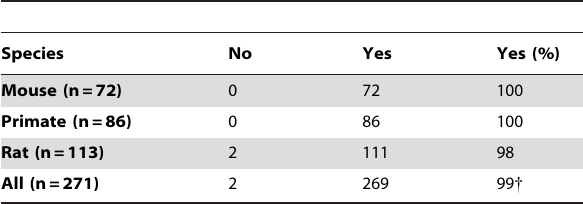
Table 6. Number of studies reporting the species or strain of the animals.